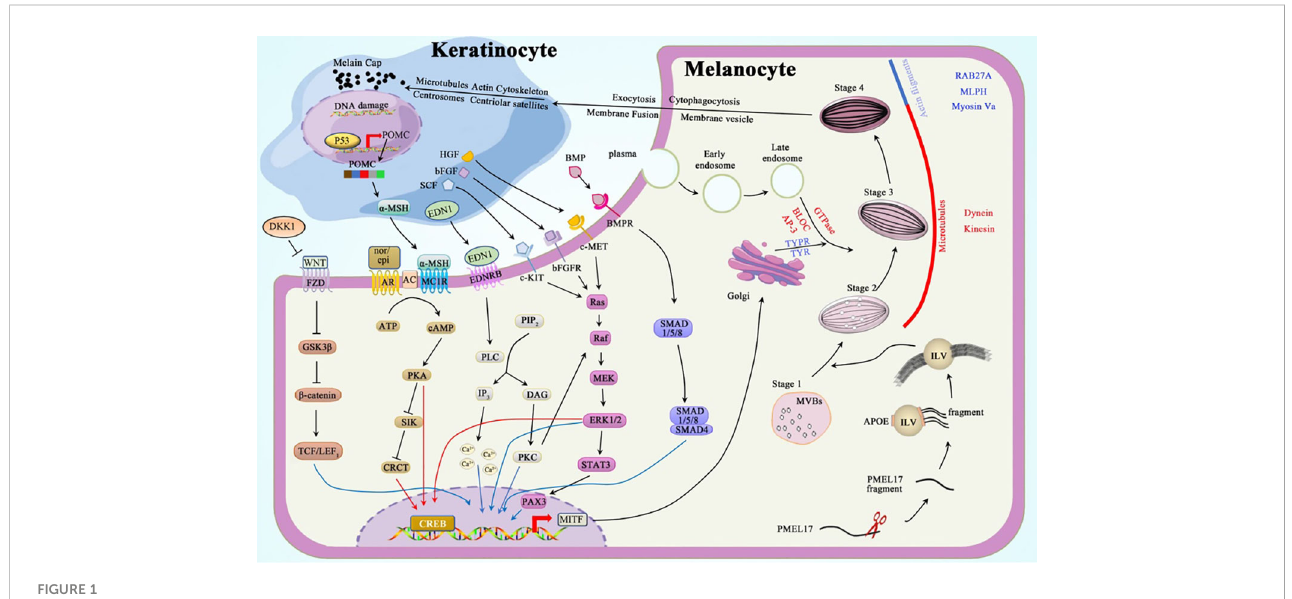
FIGURE 1 Melanogenesis and